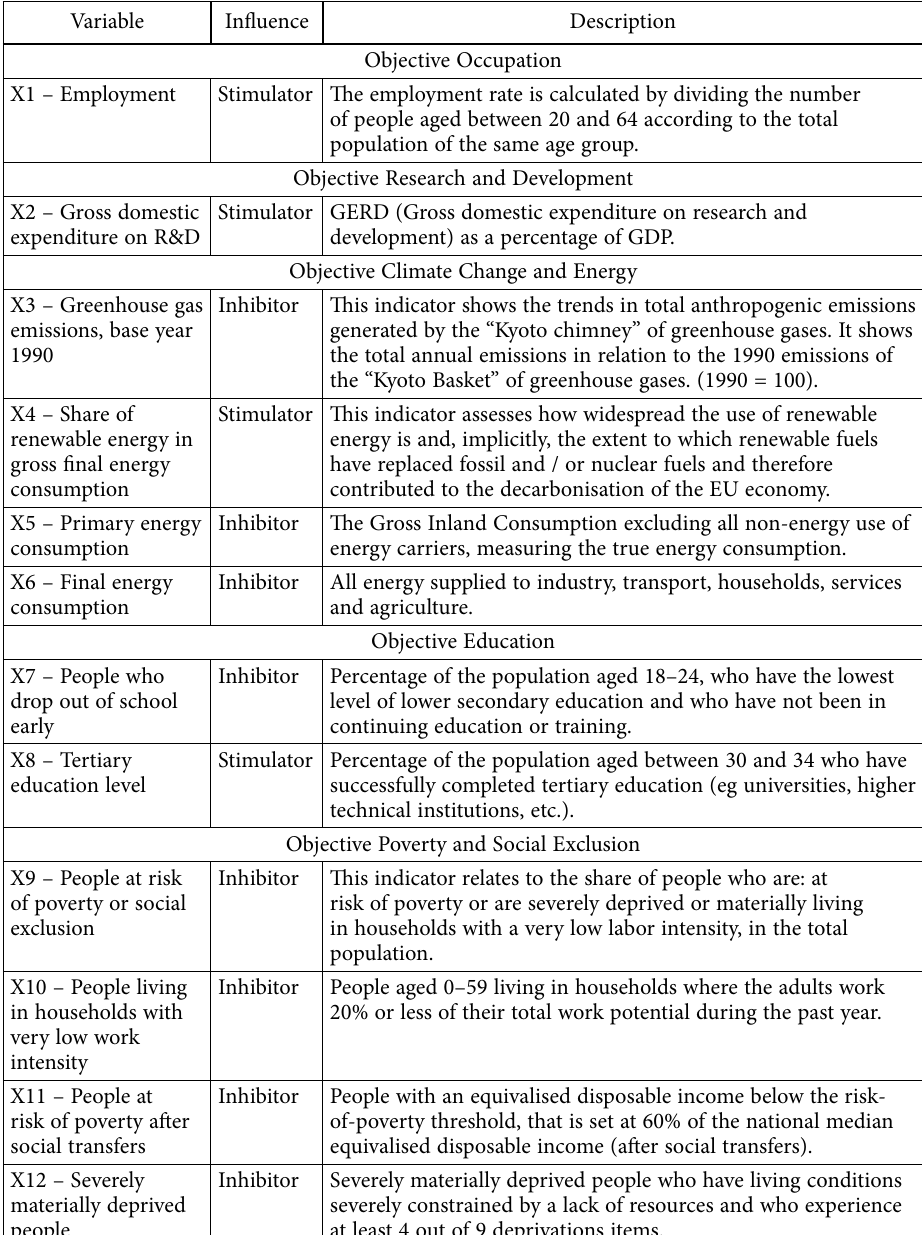
Table 1. Variables monitored under the five measurable targets under the Europe 2020 Strategy